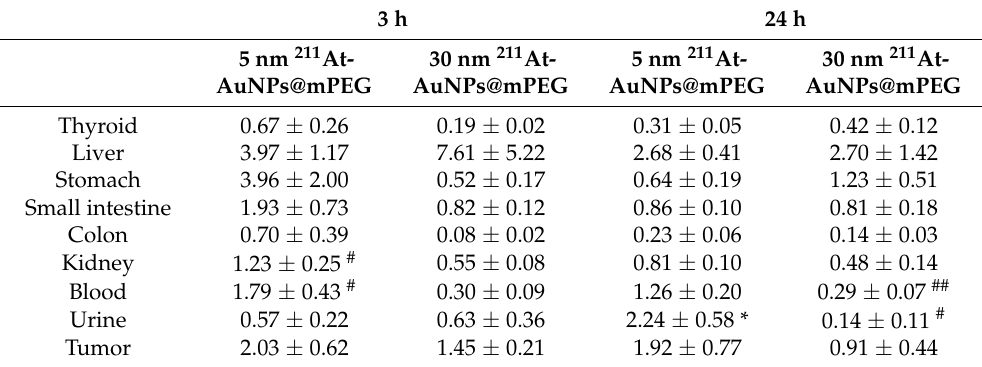
Table 2. Comparison of percentage distribution of injected dose (% ID) of 5 nm and 30 nm 211 At- AuNPs@mPEG.